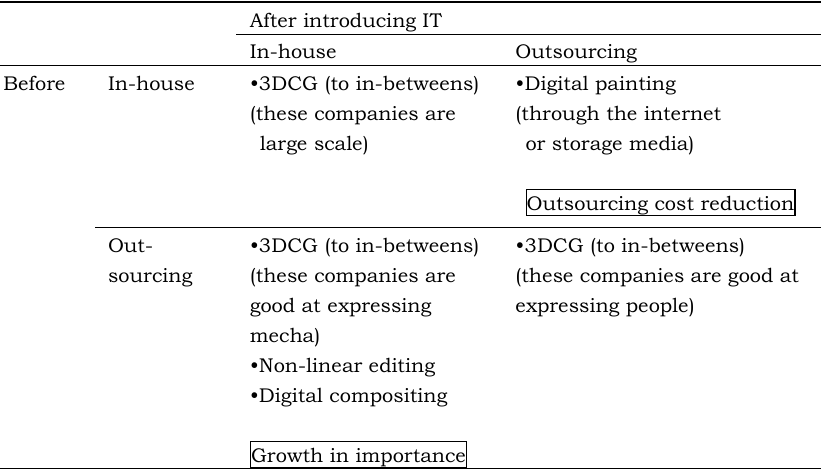
Table 2. Changes in production system after introducing